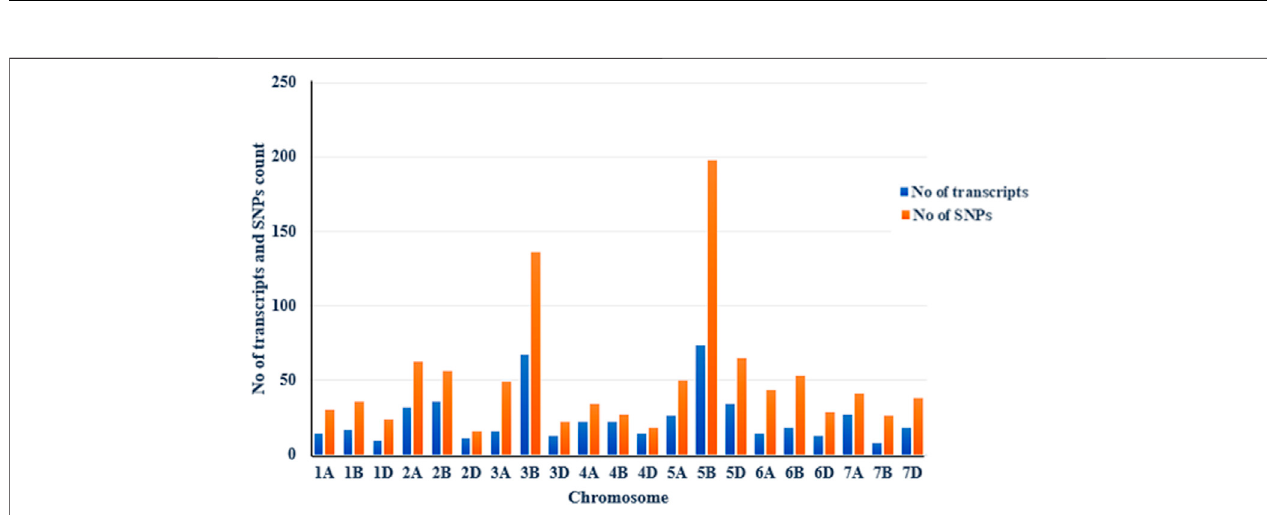
FIGURE 4 | Chromosomal distribution of SB-associated transcripts (blue bar) and polymorphic SNPs (orange bar) on wheat chromosomes with a bulk frequency ratio greater than 6. The fi gure shows that the 5B chromosome has the maximum number of SNPs, followed by the 3B.